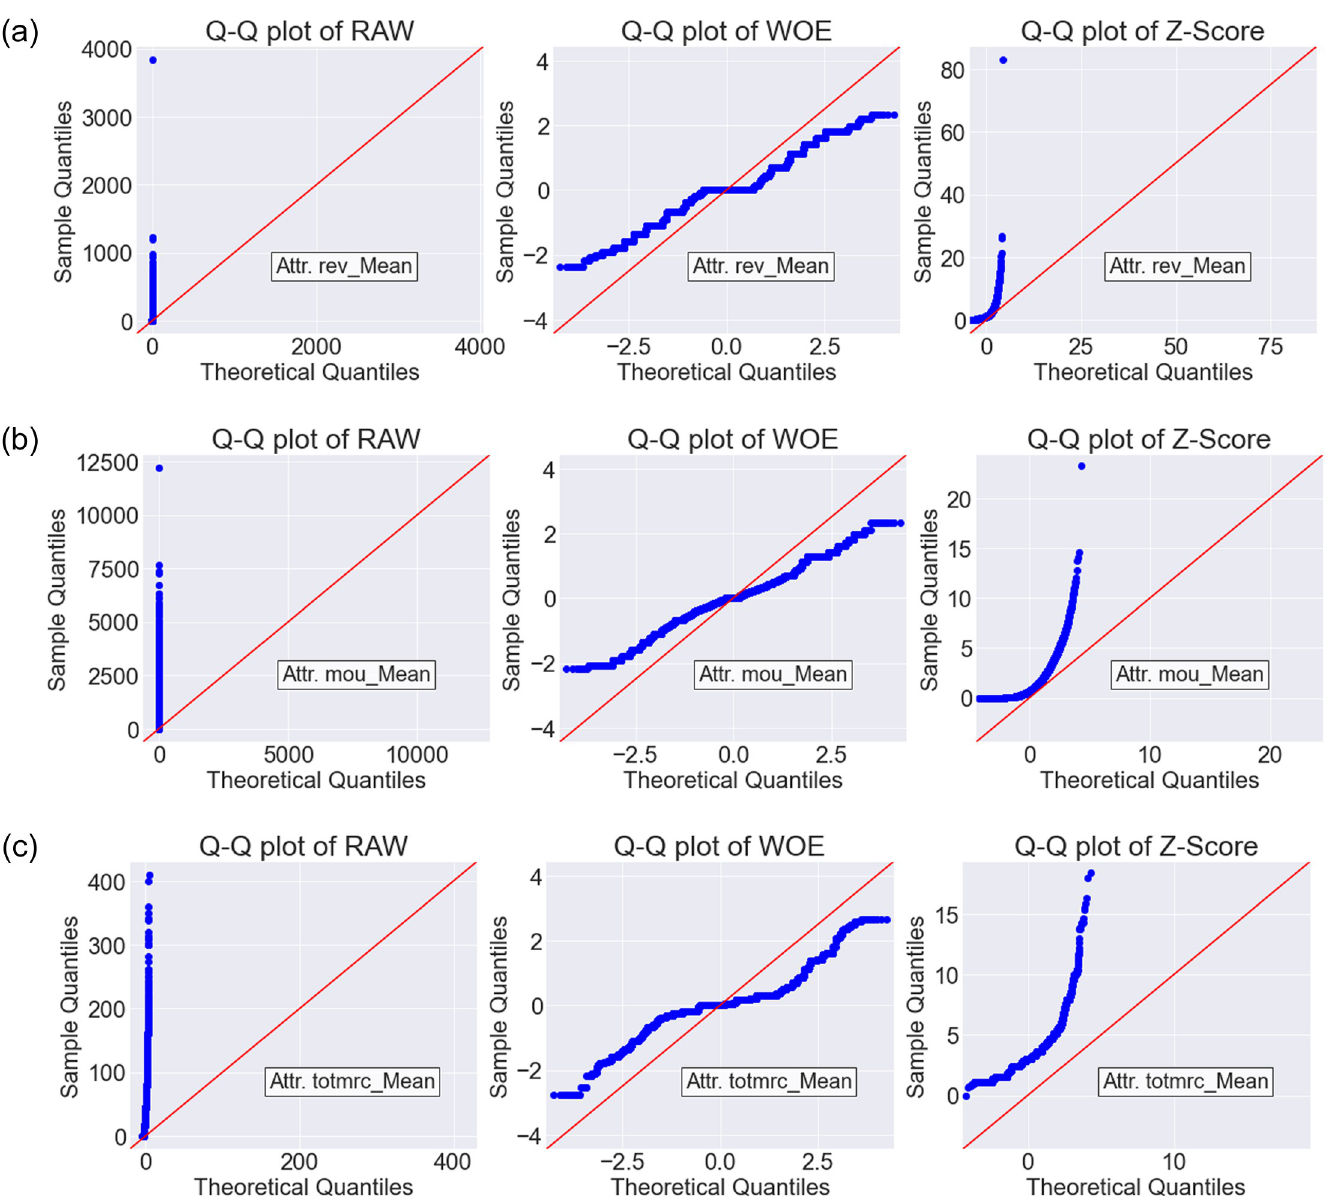
Fig 5. The Q-Q plot for RAW (without DT), WOE and Z-Score DT methods on